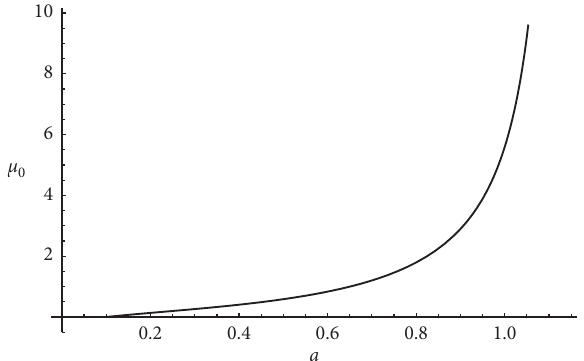
Figure 4: Values of μ